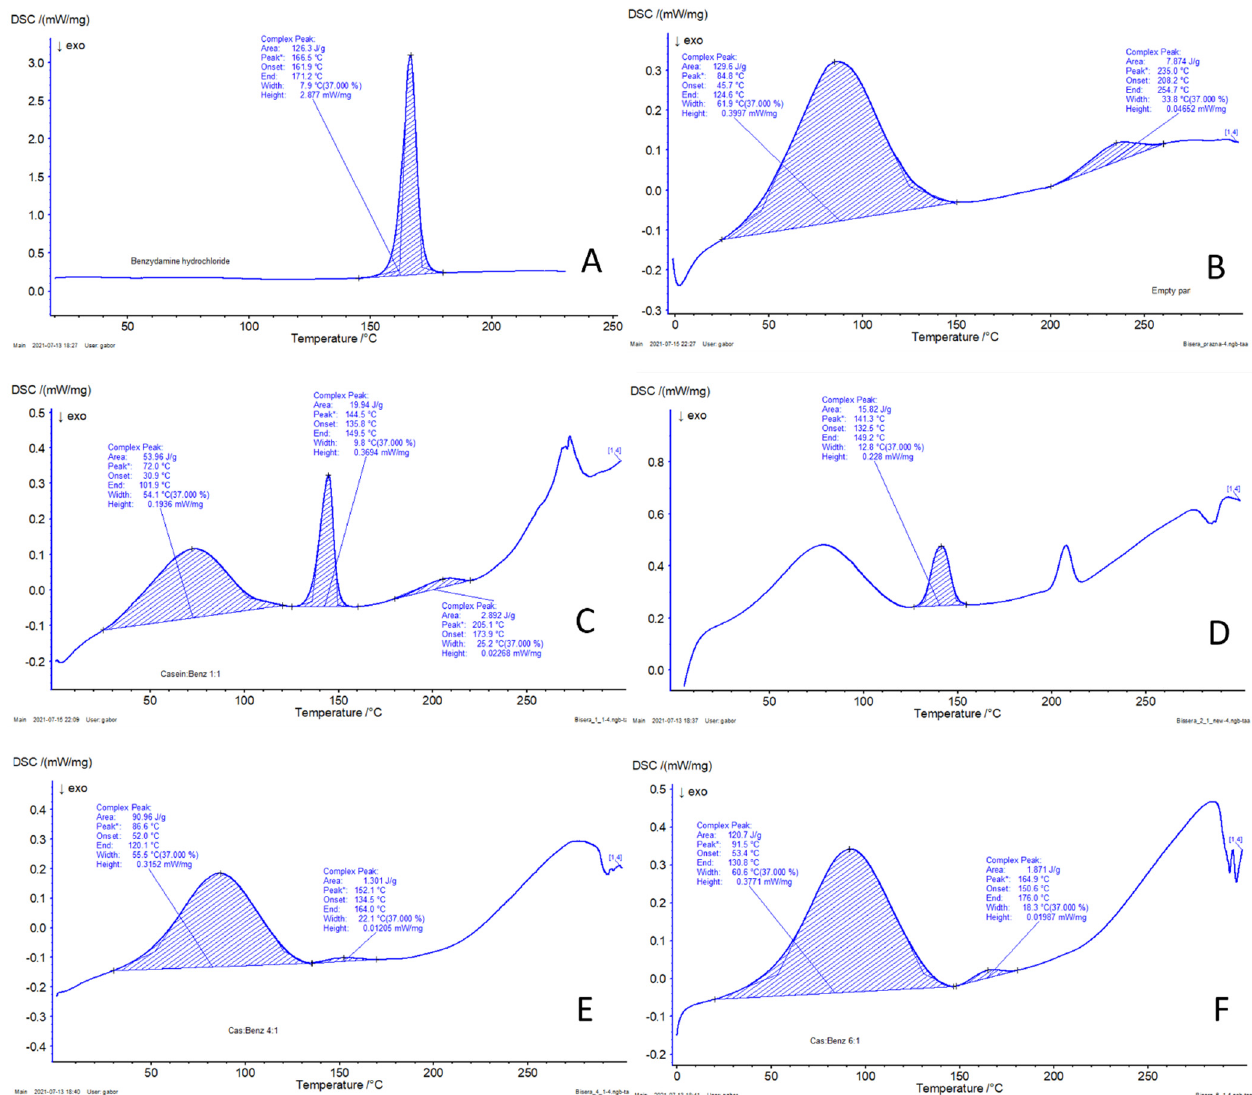
Figure 5. DSC thermograms of Benzydamine hydrochloride ( A ), blank casein nanoparticles ( B ), BZ-loaded casein nanoparticles of batches Cas2-Ca3-BZ-1 ( C ), Cas2-Ca3-BZ-2 ( D ), Cas2-Ca3-BZ-4 ( E ) and Cas2-Ca3-BZ-6 ( F ).